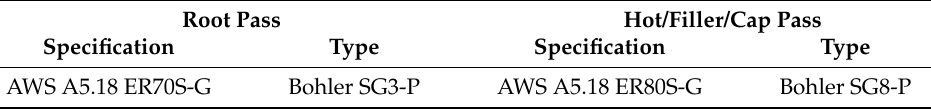
Figure 1. Design of composite V-groove. Table 2. Welding materials used in girth welding.